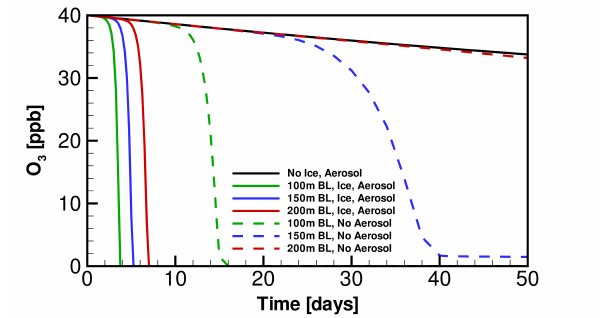
Fig. 3. Effect of the heterogeneous reaction rates on the ozone de- pletion time.